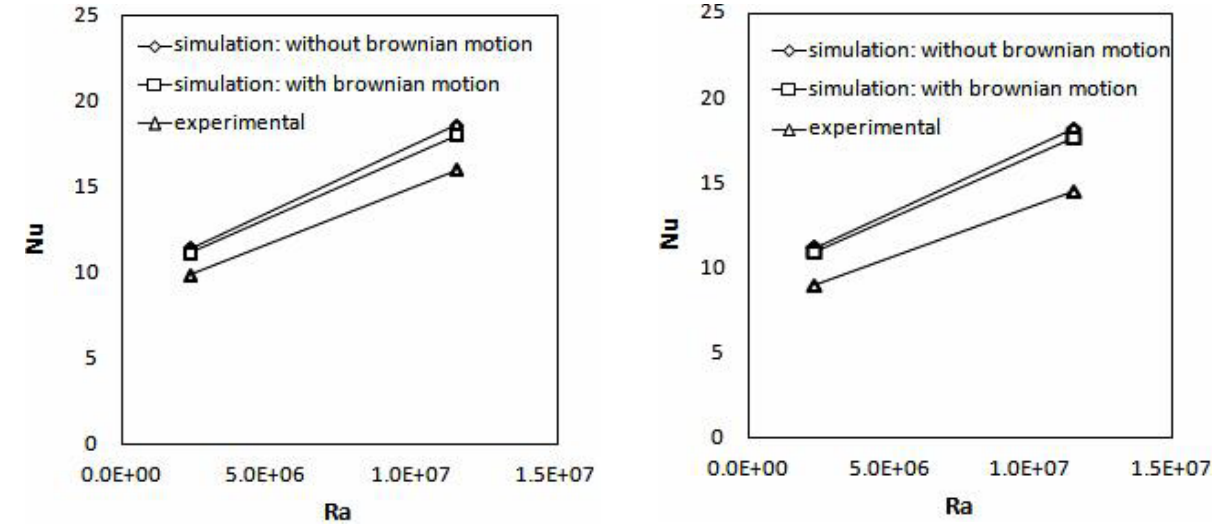
Fig. 5. Variation of Nusselt number with Rayleigh number for Ø= 1% Fig. 6. Variation of Nusselt number with Rayleigh number for Ø= 2%